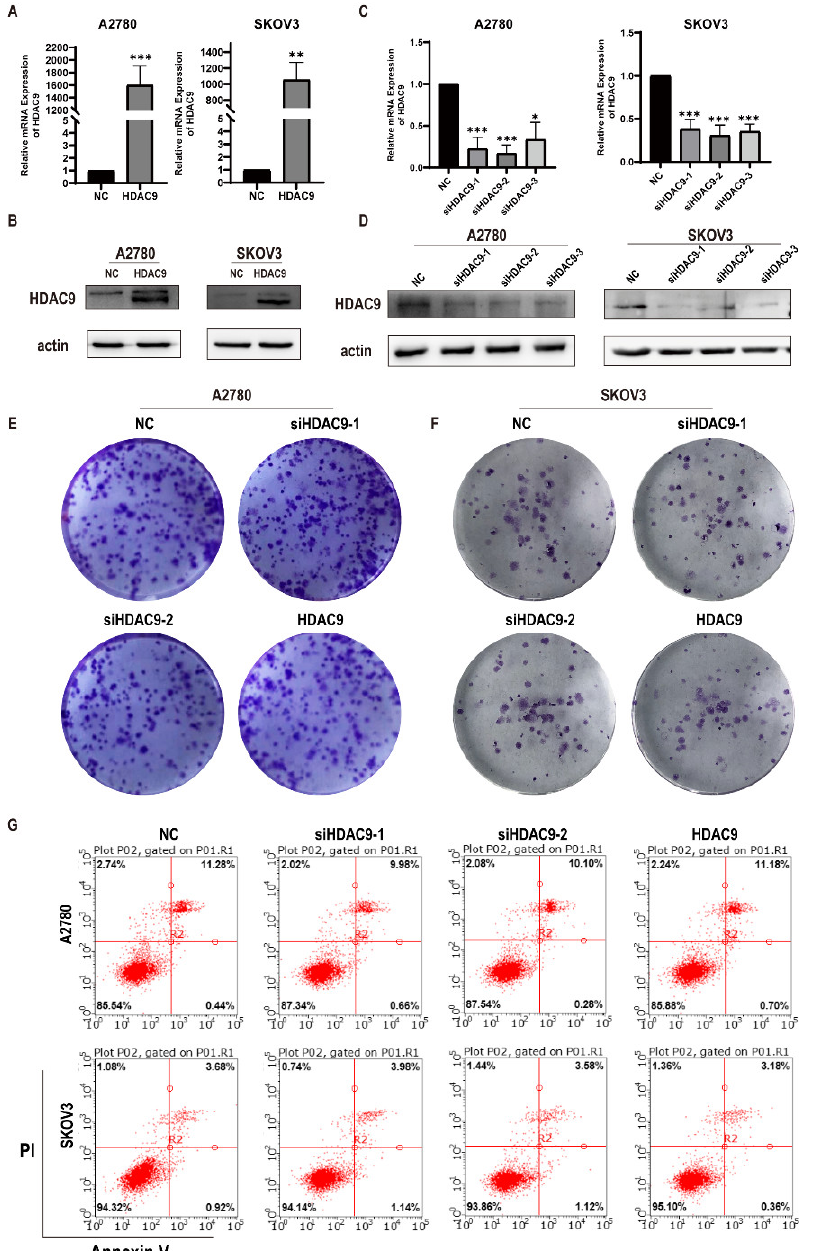
Figure 2. HDAC9 does not significantly affect the proliferation of ovarian cancer cells. A2780 and SKOV3 cells were transfected with a HDAC9 overexpression construct, HDAC9-shRNA plasmids (siHDAC9-1/2/3), or empty vector (NC) for 24 h. ( A , C ) Relative HDAC9 expression in A2780 and SKOV3 cells was measured by qRT-PCR (means ± SD, n = 3, * p < 0.05, ** p < 0.01, *** p < 0.001), compared with NC group. ( B , D ) The protein expression of HDAC9 in A2780 and SKOV3 cells was measured by Western blot. ( E , F ) Clonogenic assays were used to detect cell proliferation of A2780 and SKOV3 cells. ( G ) Annexin V/PI staining was used to detect apoptosis of A2780 and SKOV3 cells.